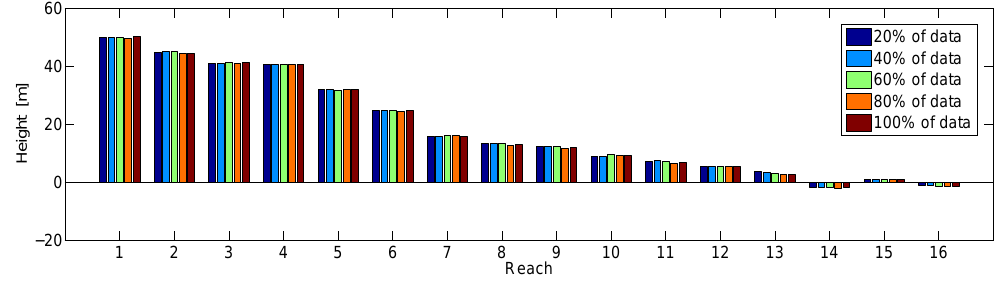
Figure 8. Estimated river bed height by considering 20%, 40%, 60%, 80% and 100% of data in the time series of water level, width and discharge along the Po River for 16 defined reaches.